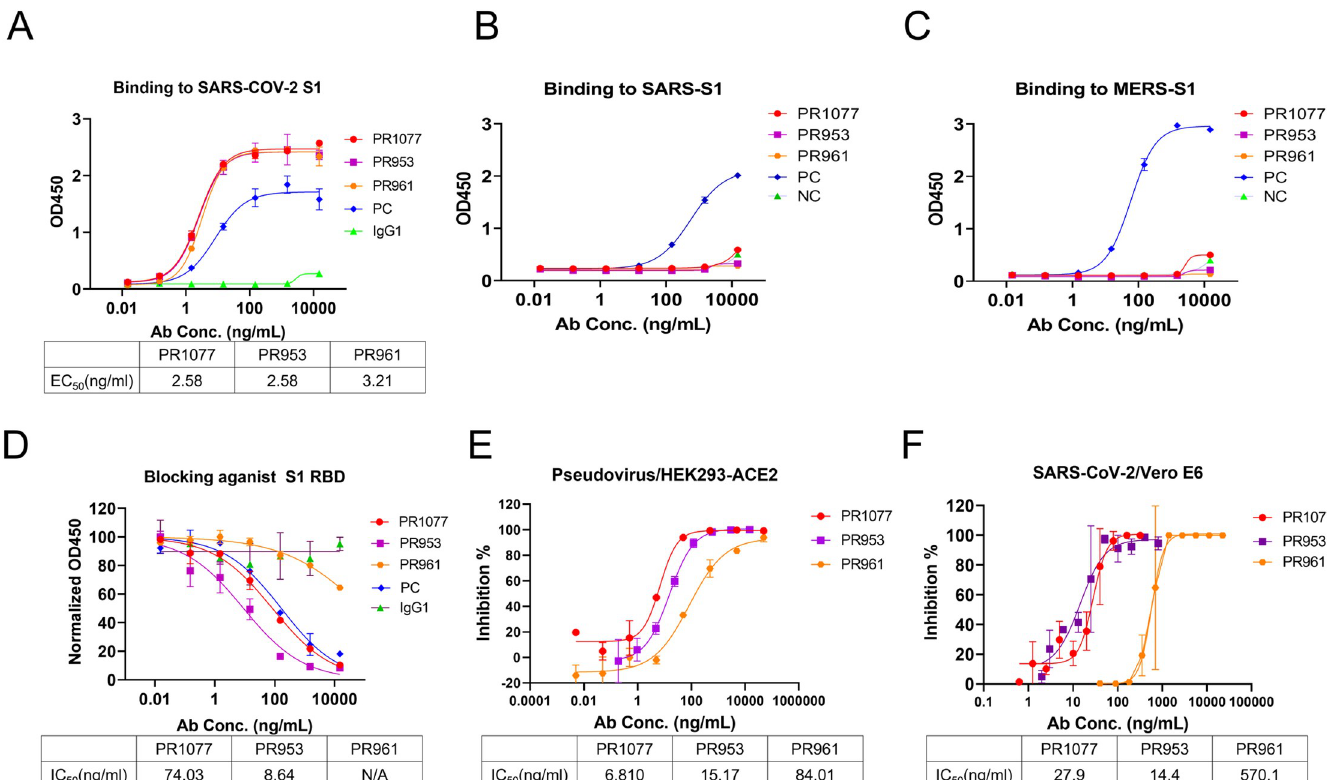
Fig 2. Characterization of the selected NAbs PR1077, PR953, and PR961. (A) ELISA binding curve of SARS-CoV-2 S1 protein. A commercially available antibody (8A5, Novoprotein, Shanghai) was applied as a PC. Normal human IgG1 was used as a negative control. All the data of this figure can be found in the S3 Data file. ELISA binding curves of SARS S1 (B) and MERS S1 (C) proteins. Internally generated antibodies were used as PCs. All the data of these figures can be found in the S4 Data and S5 Data files. (D) ELISA-based RBA of PR1077, PR953, and PR961 against RBD binding to hACE2. All the data of this figure can be found in the S6 Data file. (E) PR1077, PR953, and PR961 could effectively neutralize SARS-CoV-2 pseudovirus in vitro. SARS-CoV-2 pseudovirus was incubated with serially diluted antibodies. The mixture was added to HEK293-hACE2 cells for 48 hours. The neutralization potency of each antibody was evaluated in a luciferase assay system. All the data of this figure can be found in the S7 Data file. (F) PR1077, PR953, and PR961 showed strong neutralizing potency against live SARS-CoV-2 virus in vitro. The mixture of live SARS-CoV-2 virus and serially diluted PR1077 were added to Vero E6 cells. After 1 hour, cells were washed and further incubated for 48 hours before detection of infected cells by an immunofluorescence assay. All the data of this figure can be found in the S8 Data file. ELISA, enzyme-linked immunosorbent assay; NAb, neutralizing antibody; PC, positive control; RBA, receptor blocking assay; SARS-CoV-2, Severe Acute Respiratory Syndrome Coronavirus 2.